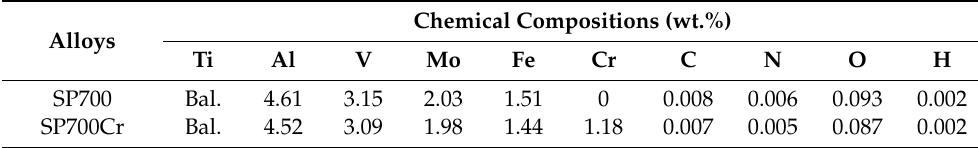
Table 1. Chemical composition of the forged SP700 and SP700Cr alloys.